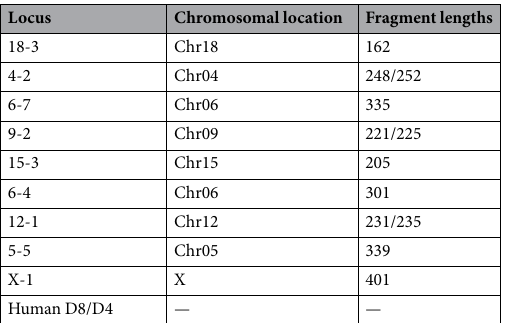
— — Table 3. Mouse DNA profile of e-CAS cell line. * DNA profile performed by Microsynth AG using highly- polymorphic short tandem repeat loci (STR) published by Almeida et al . 13